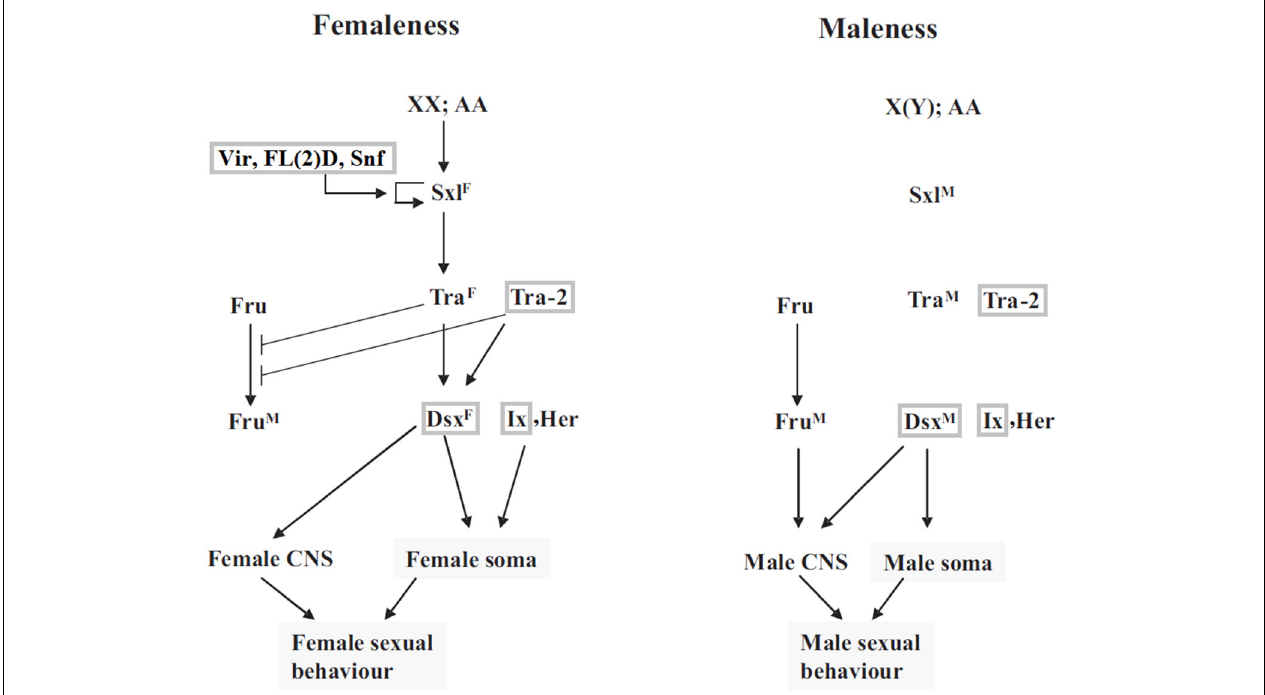
FIGURE 1 | Sex determination pathway in Drosophila , modified from Sánchez (2008). Sxl F and Sxl M refer to functional female and nonfunctional male isoforms of the Sxl protein, respectively. Tra F is the functional female form of the Transformer protein, which in conjunction with the constitutive gene product Tra-2 controls female-specific splicing of dsx and fru . snf , vir and FL(2)D are required for late female-specific splicing of Sxl but play no part